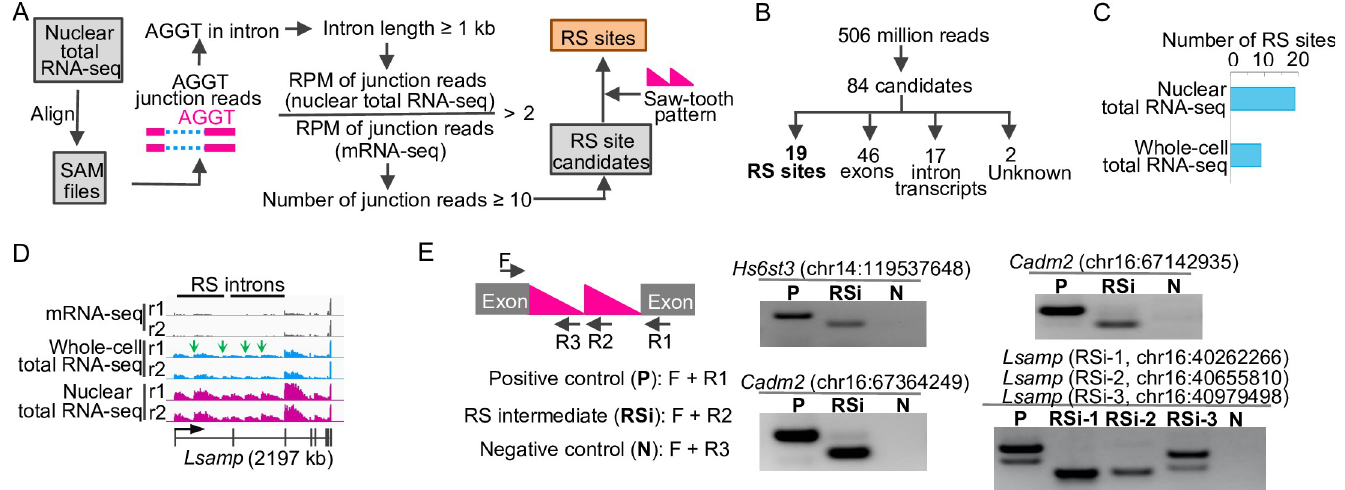
Fig 2. Identify RS sites using nuclear total RNA-seq data. (A) Schematic of the pipeline using nuclear total RNA-seq data to identify RS sites. (B) The 84 RS candidates. (C) Bar plot of RS sites identified using the two sequencing methods in the mouse cerebral cortex. (D) Sequencing profile at Lsamp locus. Green arrows indicate the four novel RS sites. (E) Using RT-PCR to detect RS splicing intermediates. Left, schematic of the primer design. Right, RT-PCR and gel results. Note, there are two bands in the positive control and RSi-3 in Lsamp , because there is an alternative splicing exon (60 bp) located between RS site 2 and RS site 3 in Lsamp .